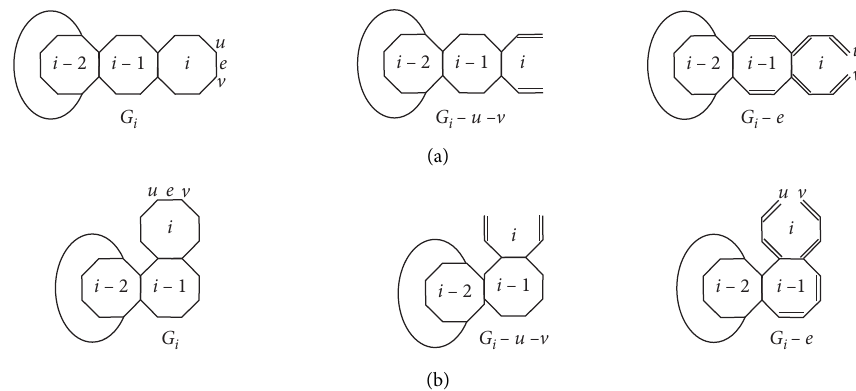
Figure 3: Illustrations of case 1 in Lemma 1: (a) type A ; (b) type L .